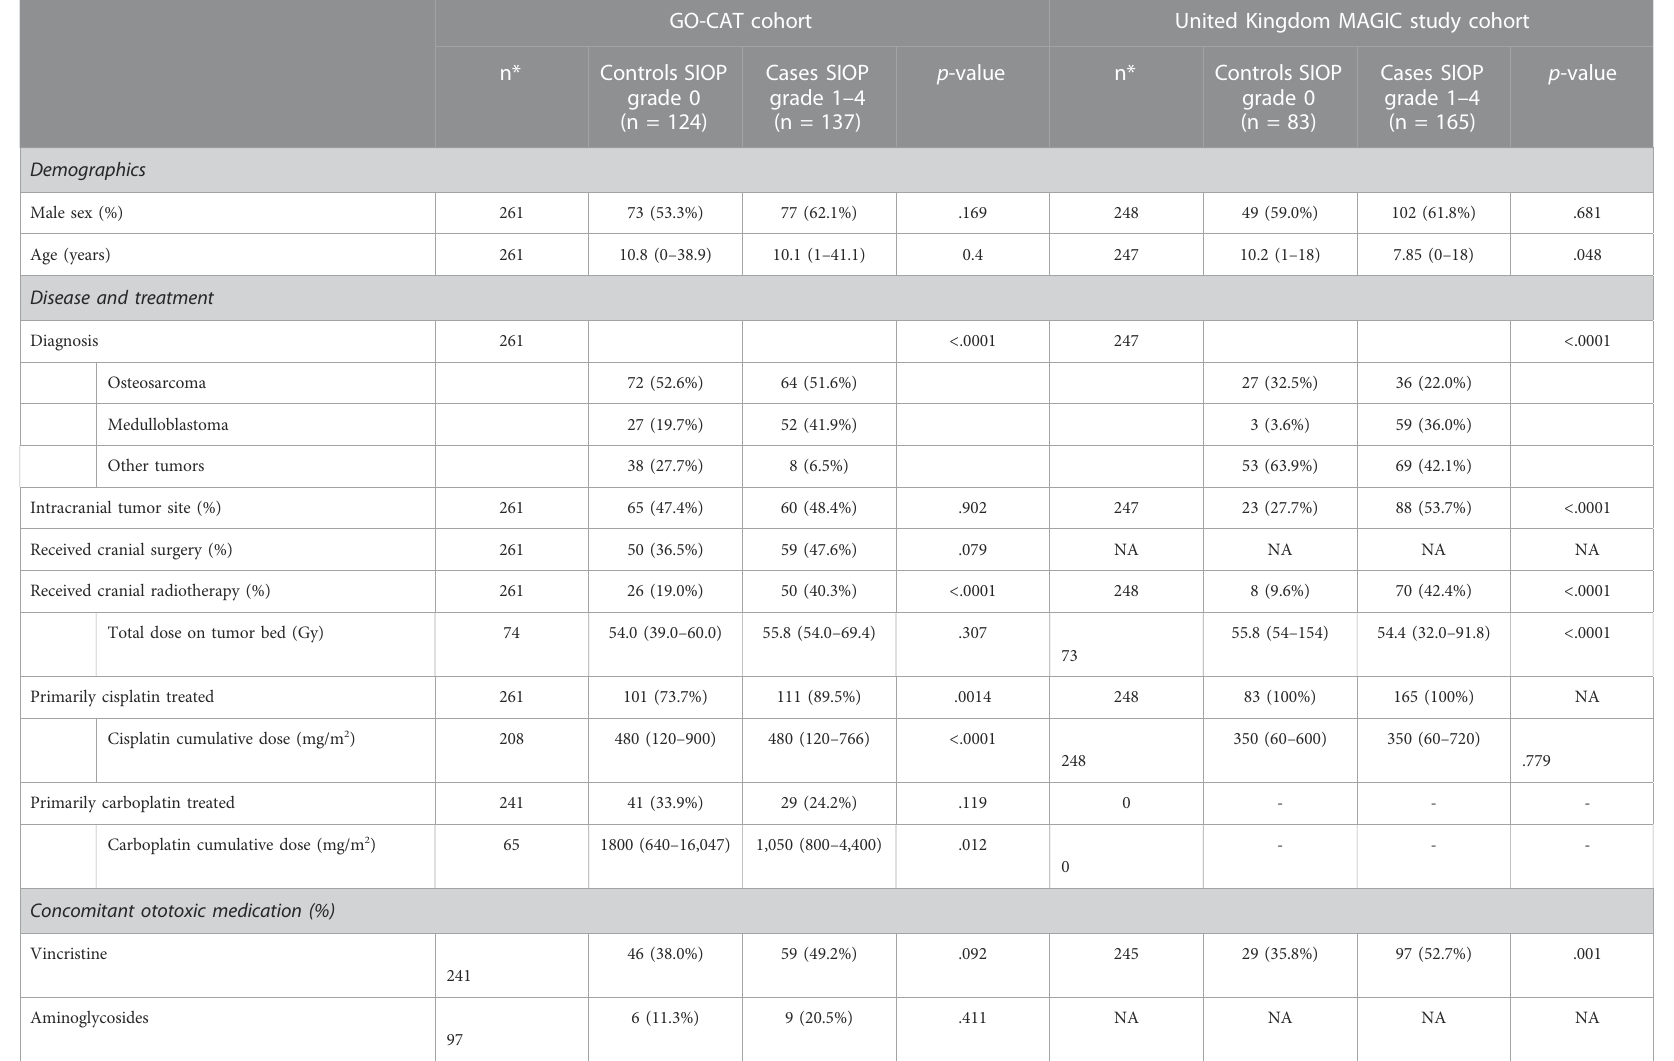
TABLE 1 Demographic data of patients in the discovery cohort of pediatric cancer